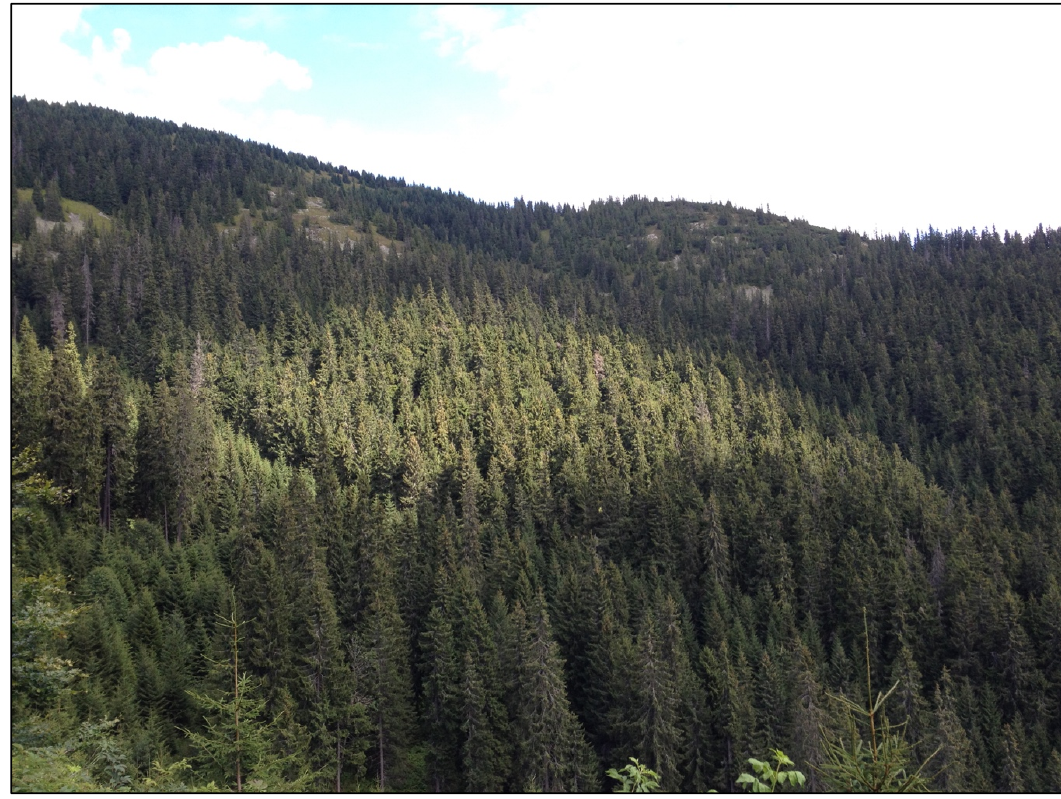
Figure 1. The first phase of a bark beetle calamity in the Low Tatras (Photo by J. Lastovicka). Table 1. Overview of the selected localities in the Low Tatras NP with the GPS position in WGS 84.